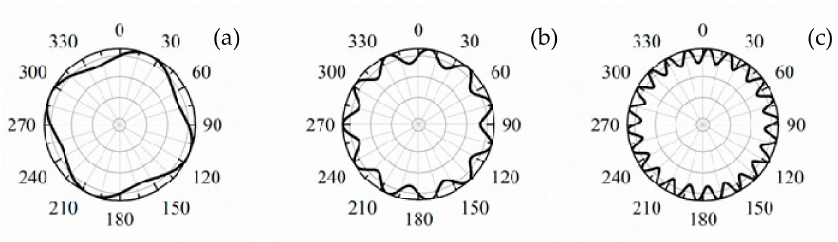
Figure 1. Typical wheel polygons with di ff erent harmonic orders: ( a ) fourth-order; ( b ) 11th-order; and ( c )